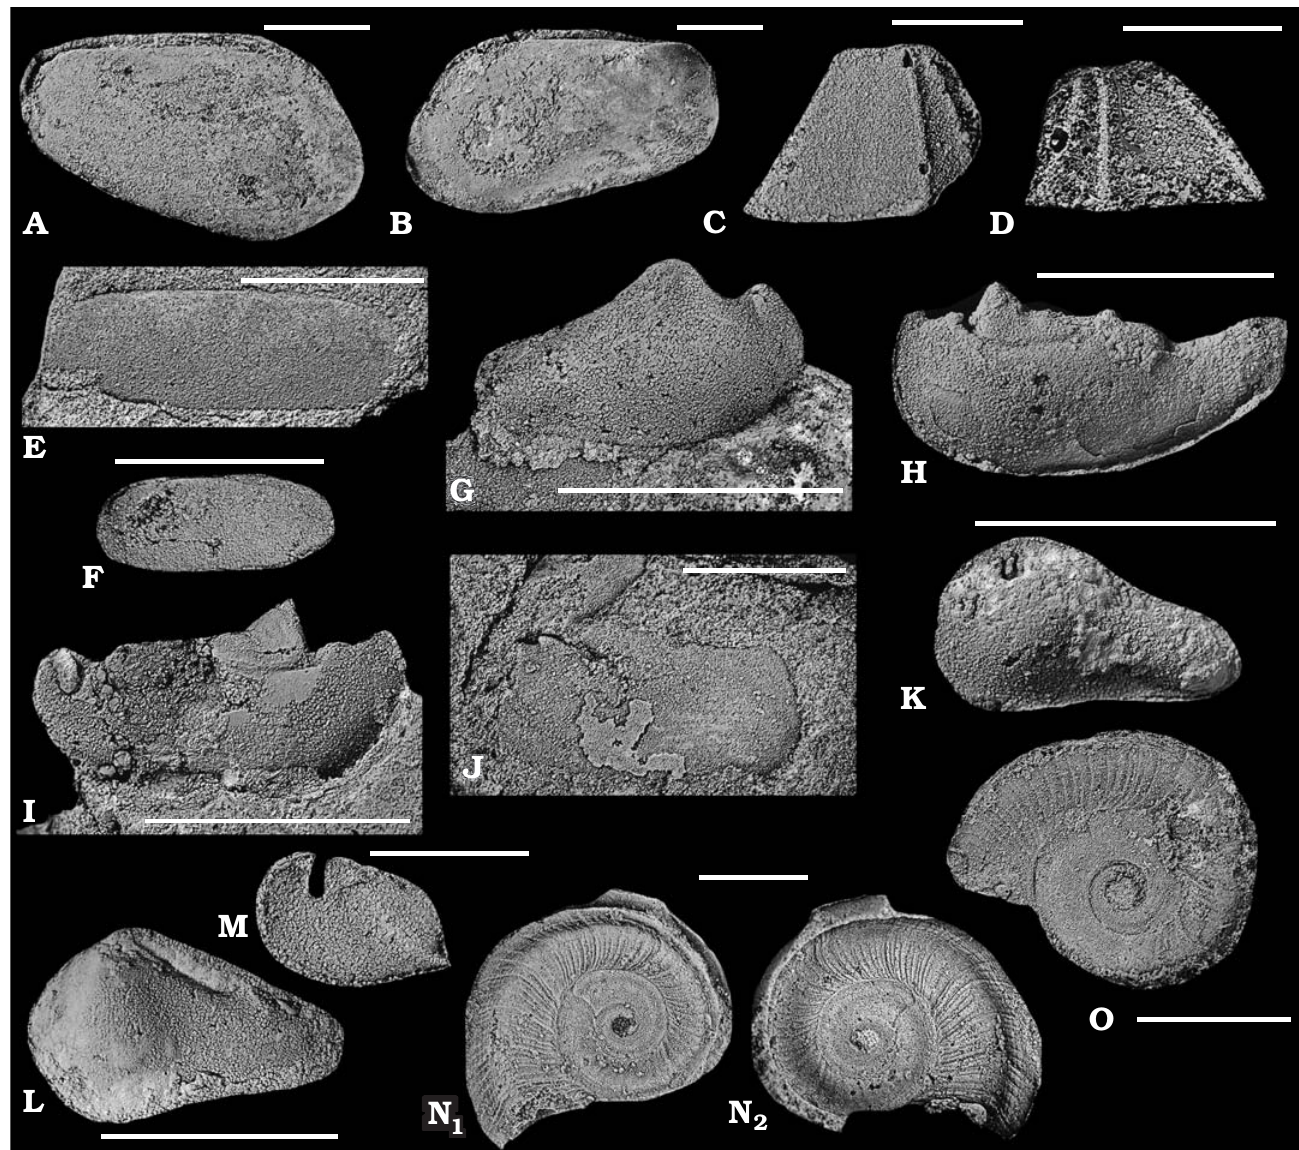
Fig. 12. Pteriomorphian and heteroconchian bivalves, rostroconchs and gastropods from the Stairway Sandstone, Middle Ordovician, Australia. Internal moulds (A, B, E–M, N 1 ) and latex casts of internal (N 2 , O) and external (C, D) moulds. A , B . Modiolopsis pojetai sp. nov. from Petermann Creek. A . Holotype (CPC 41481) in left-lateral view showing discrete longitudinal dorsal slit-like mark. B . Paratype (CPC 41482) in right-lateral view with umbo steeply descending anteriorly. C , D . Colpantyx ? sp. A from Areyonga Gorge; in right ( C , CPC 41483) and left-lateral ( D , CPC 41484) views with two umbonal radial ribs anteriorly and one posteriorly. E , F . Spheno solen draperi Pojeta and Gilbert-Tomlinson, 1977 from Petermann Creek ( E , CPC 41485; F , CPC 41486), specimens with flat shell and narrow elongated sub-rectangular shape. G–M . Rostroconchia. G–I . Ribeiria csiro Pojeta, Gilbert- Tomlinson, and Shergold, 1977 from Areyonga Gorge (G) and Petermann Creek (H – I); note the prominent triangular beak and curved ventral margin ( G , CPC 41487; H , CPC 41488; I , CPC 41489). J . Ribeiria jonesi ? from Petermann Creek, sub-rectangular profile and strong dorsally projecting umbo (CPC 41490). K , L . Pinnocaris sp. A from Petermann Creek with inflated pear-shaped profile ( K , CPC 41491; L , CPC 41492). M . Technophorus walteri Pojeta, Gilbert-Tomlinson, and Shergold, 1977 from Areyonga Gorge (CPC 41493) with a single lateral radial rib and prominent nearly erect pegma indi- cated. N , O . Gastropoda, Scalites ? sp. from Petermann Creek. N . CPC 41494 (N 1 ), latex cast with clear growth lines (N 2 ). O . CPC 41495, specimen with 3.5 to 4 whorls. Scale bars 10 mm, except C, D, M, 5